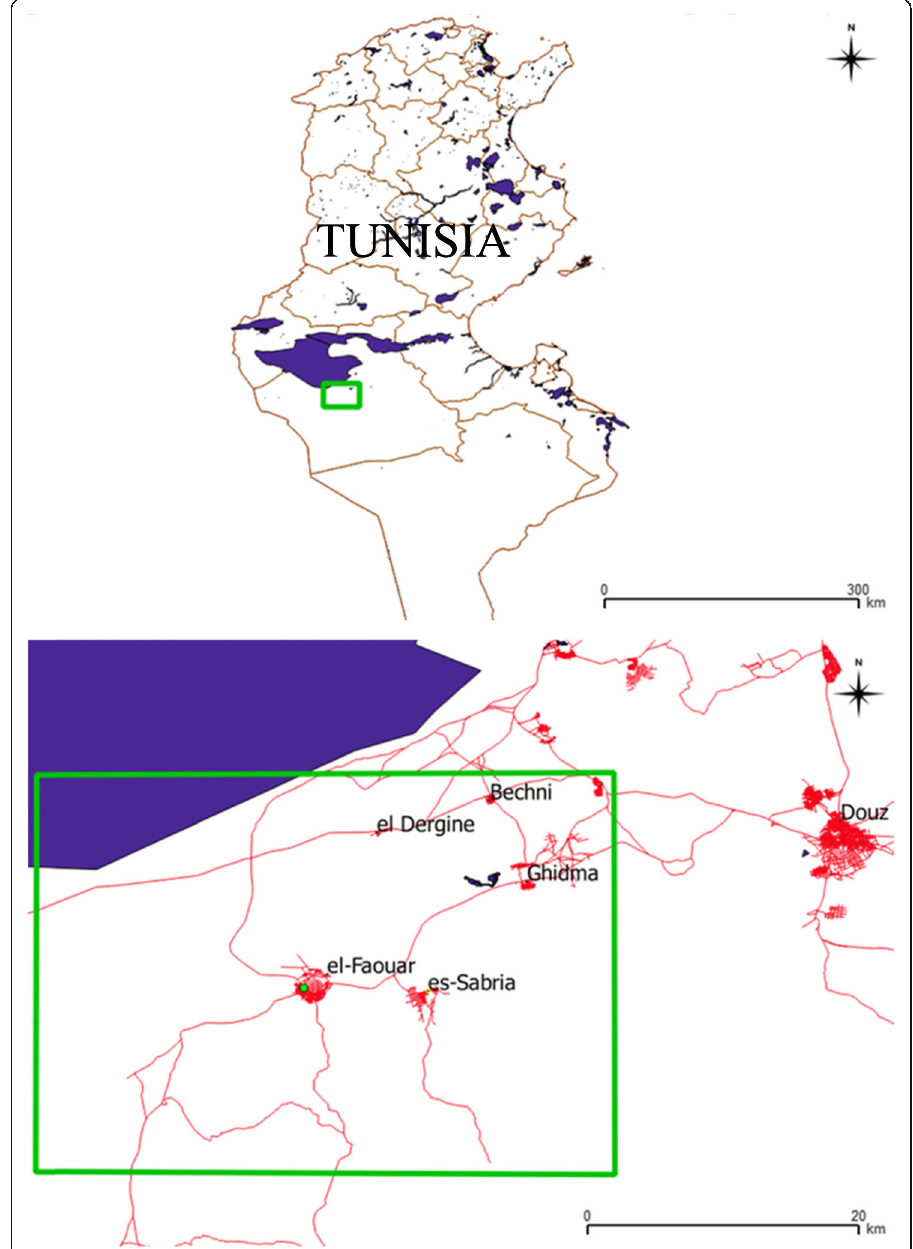
Fig. 1 The location of the research area (green rectangle) in Tunisia (top) and location of particular oases in El Faouar delegation (bottom) (prepared by K.